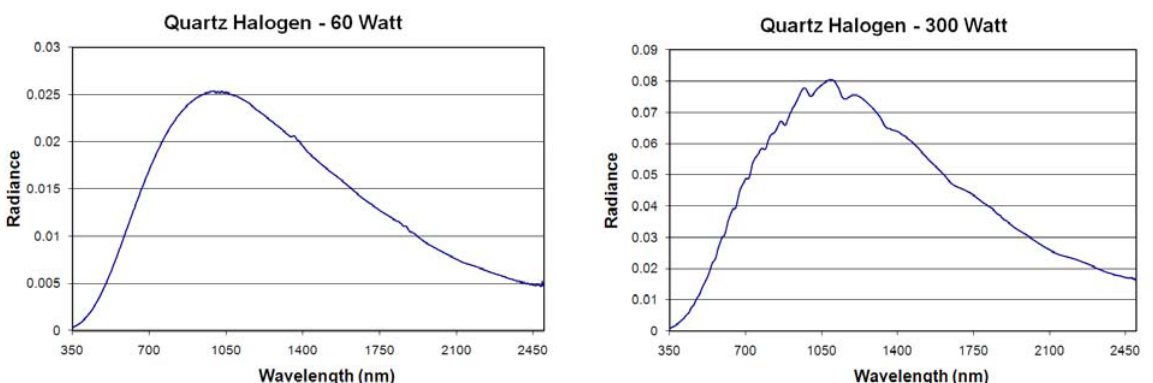
Figure 8. Emission spectra of quartz halogen